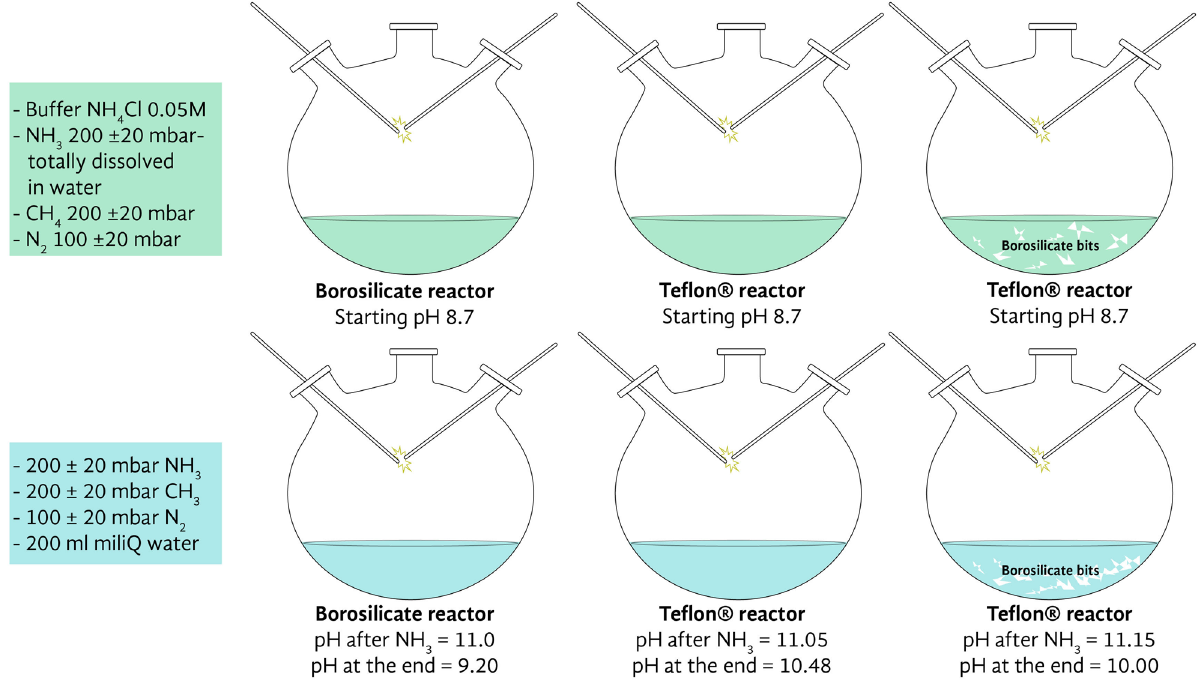
Figure 1. The experimental design. Six electric discharge experiments were performed in two different flasks, one made of borosilicate glass, the other of Teflon. Three experiments were performed to test the effect of the borosilicate glass. One in the borosilicate reactor, one in the Teflon reactor, a third one in the Teflon reactor containing pieces of borosilicate glass. The three experiments were repeated with NH 4 Cl buffer at pH 8.7 and without buffer at pH ca.